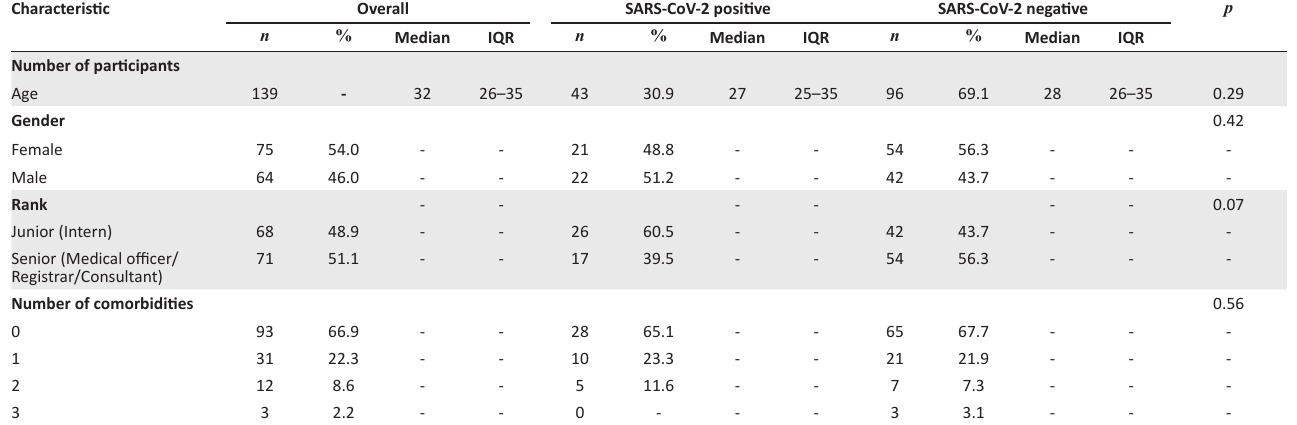
TABLE 1: Demographic characteristics of surveyed Nelson Mandela Bay Public Hospital medical doctors.